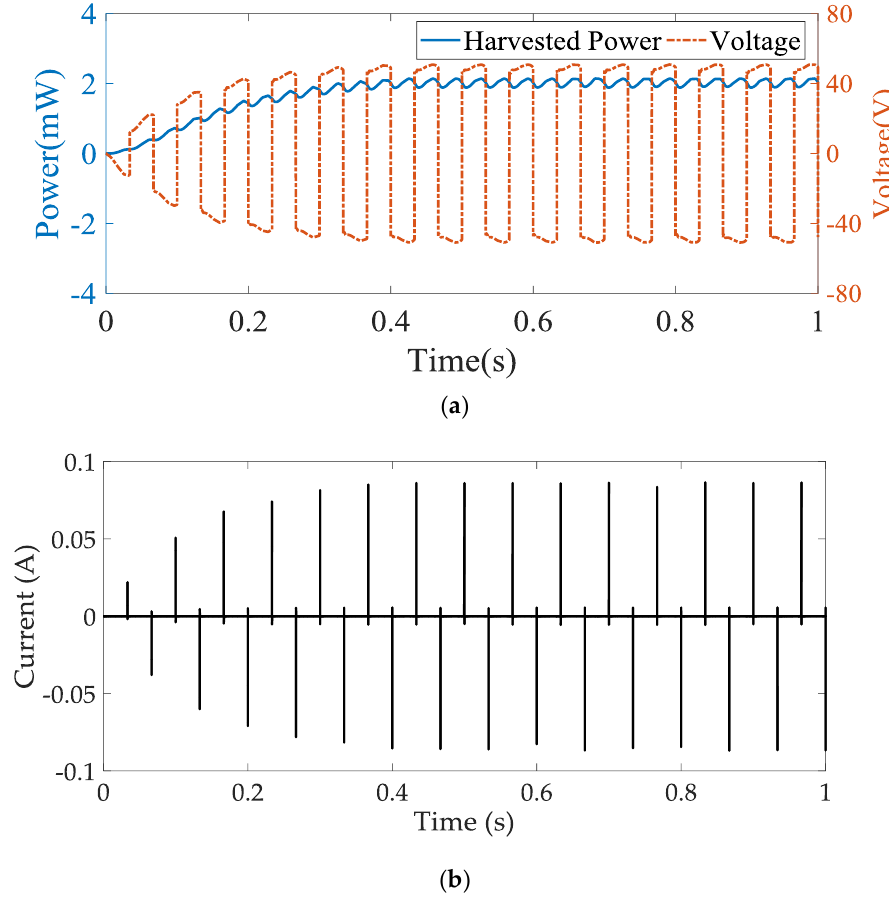
Figure 8. Working waveforms of the P-SSHI circuit in the simulation. ( a ) Harvested power and voltage across the piezoelectric capacitor; ( b ) Output current from the piezoelectric element.